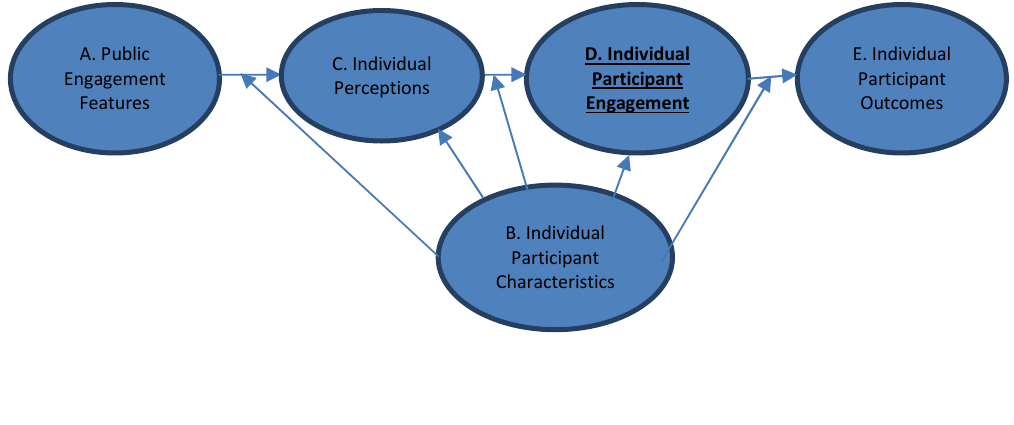
Figure 1. A General Framework for the Study of Public Engagement at the Level of the Individual, with a Focus on Participant Individual Engagement (Element